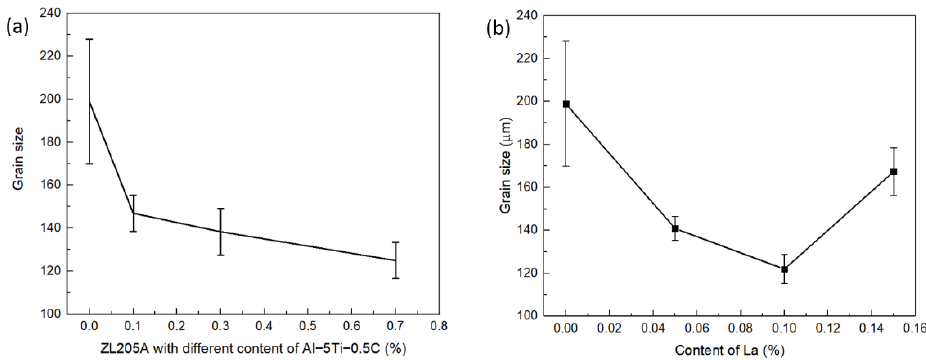
Figure 4. Microstructure of ZL205A alloy with different levels of Al−Ti−C or La: ( a ) ZL205A, ( b ) 0.1% Al−Ti−C , ( c ) 0.3% Al−Ti−C , ( d ) 0.7% Al−Ti−C , ( e ) 0.05% La, ( f ) 0.1% La, ( g ) 0.15% La, ( h ) 0.3% Al−Ti−C + 0.1% La.